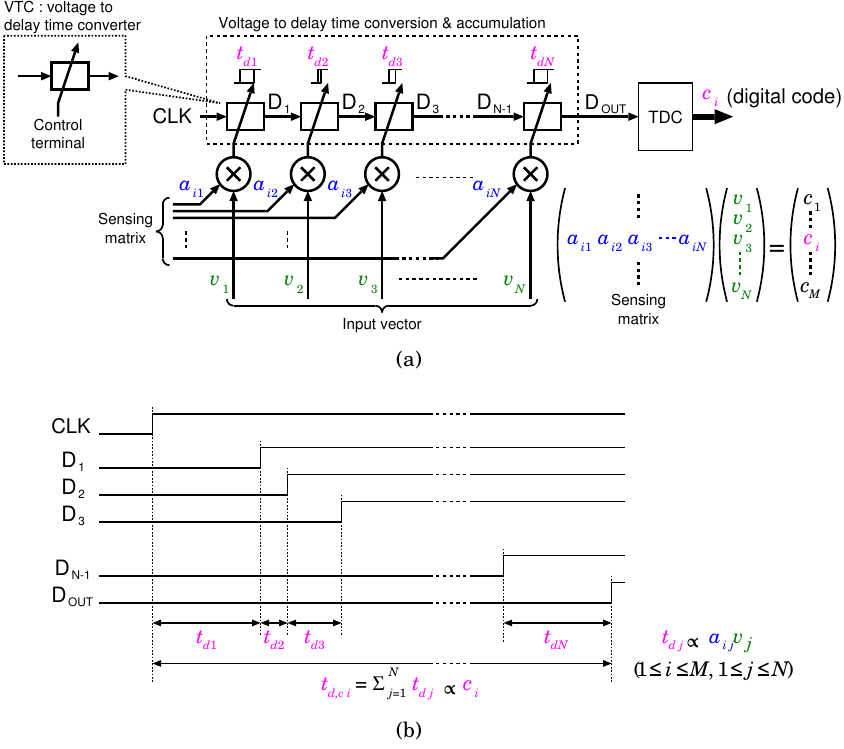
Figure 2. ( a ) Concept of the proposed time-domain analog spatial CS encoder and ( b ) timing chart for expressing its